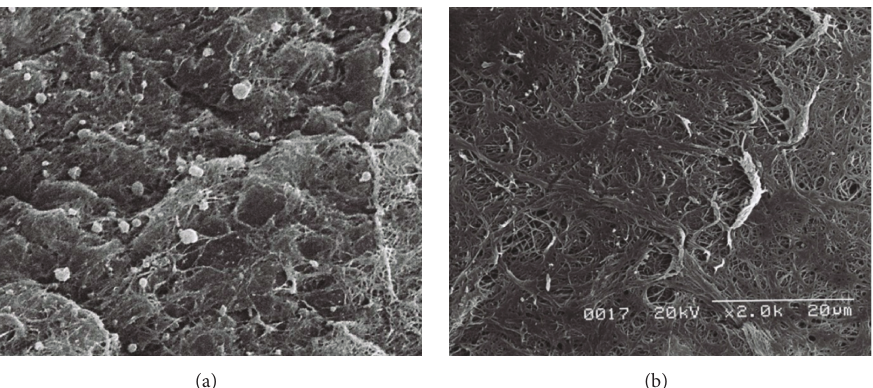
Figure 7: Residual ICG particles on the iris surface were observed using scanning electron microscopy. There were many ICG granules on the iris of the right eye of Rabbit Number One, ranging in size from 1 to 5 𝜇 m (a). However, no similar granules were observed in the control eye (b).